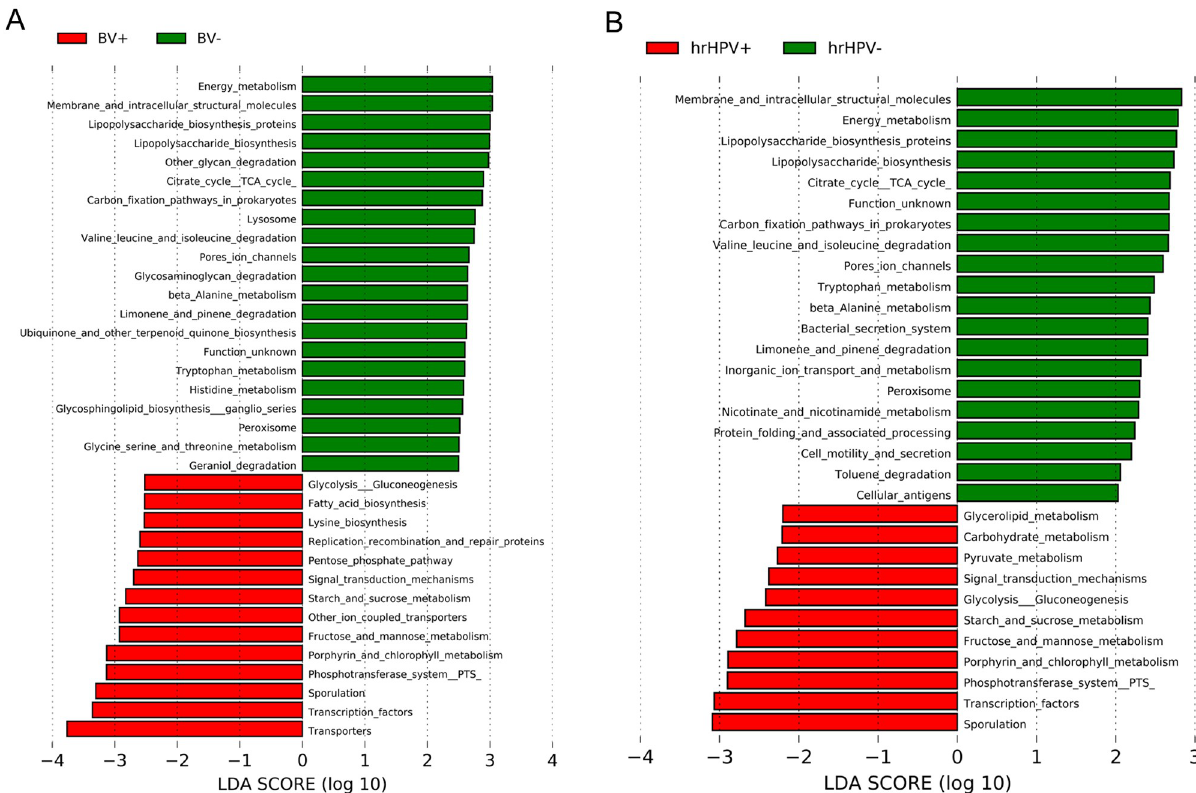
Fig 6. LEfSe histogram of the differentially enriched inferred KEGG functional categories. (A) Differentially abundant modules in women with and without bacterial vaginosis (BV). For better visualization, only modules with logarithmic LDA scores > 2.5 (absolute values) are shown. (B) Differentially abundant modules in women with and without high-risk human papillomavirus (HR-HPV) infection. Only modules with logarithmic LDA scores > 2.0 (absolute values) are shown.